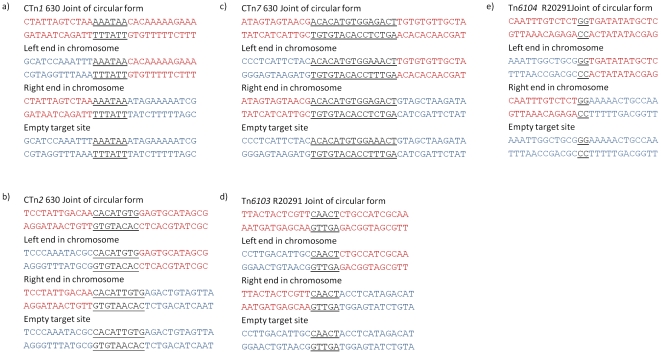
Sequences of the joints of circular intermediates element-genome junctions and regenerated target sites after excision.Sequence in red is part of the transposons, blue is part of the chromosome. Terminal repeats are underlined. a) CTn1, b) CTn2, c) CTn7, d) Tn6103 in R20291, e) Tn6104 in R20291 sequenced across the circular joint and left and right ends in the target site only.